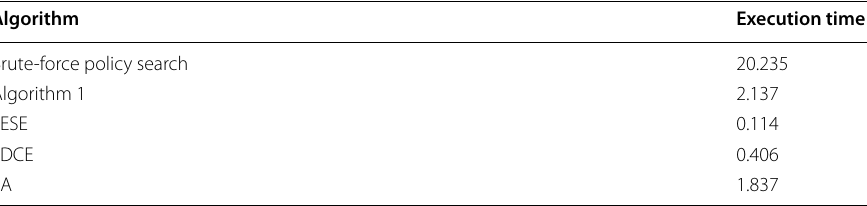
Table 1 Execution time of different